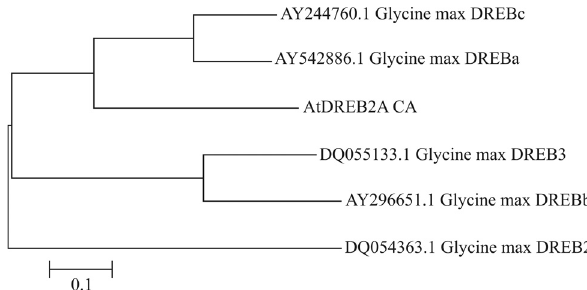
Figure 3 - Phylogenetic tree generated from CDS sequences of the soy- bean DREB gene. The sequences were obtained from the NCBI website and were aligned and clustered using Clustal X and MEGA 4.0, respec- tively.